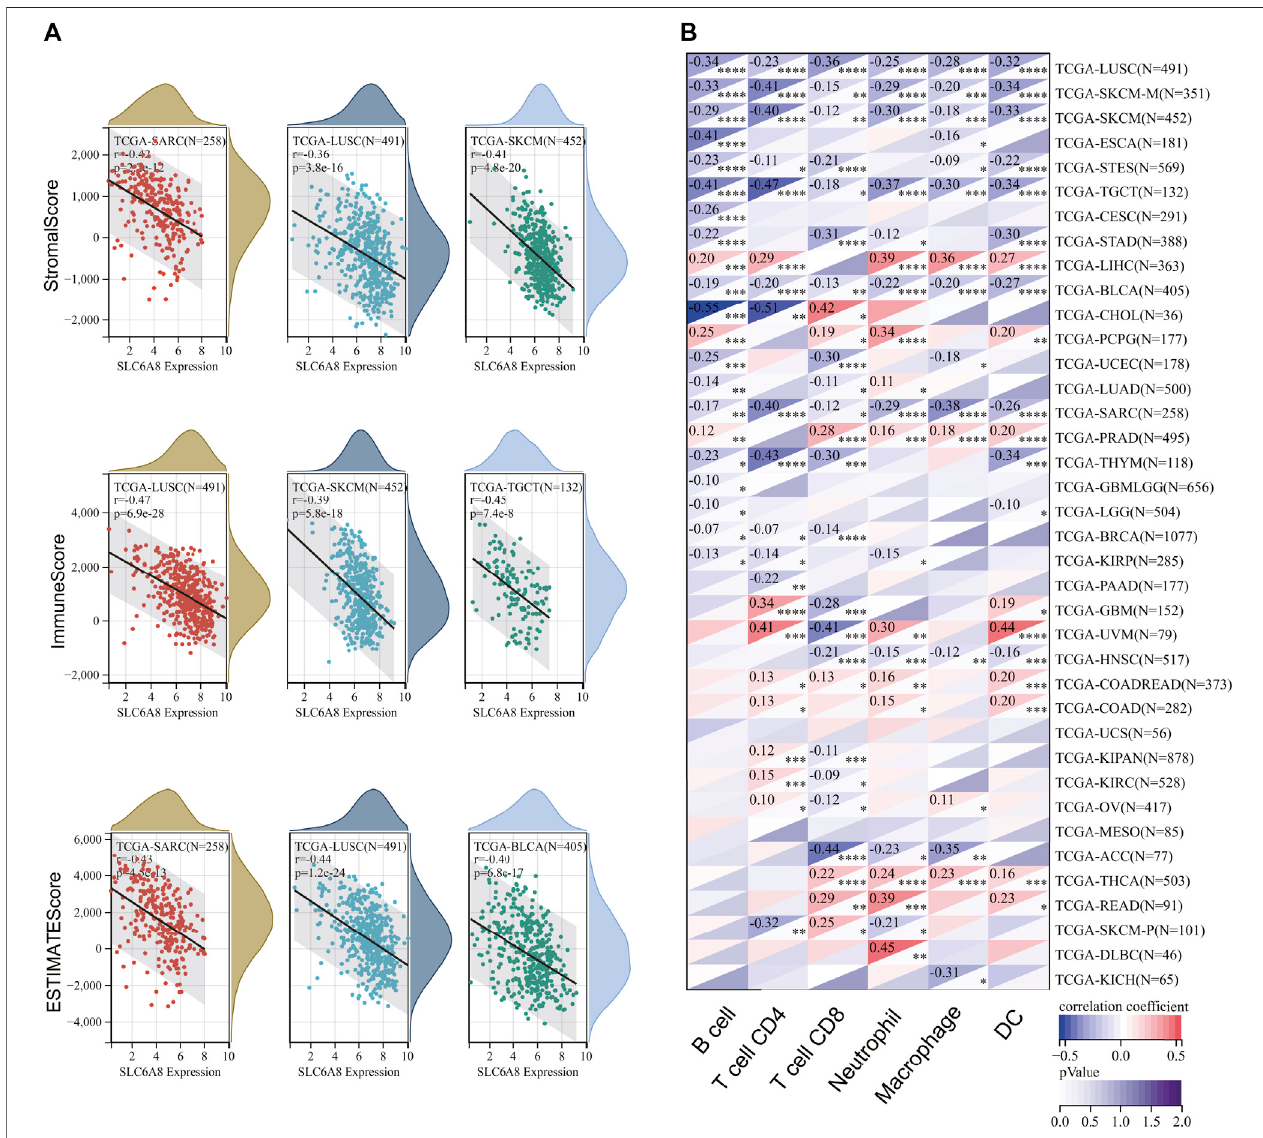
FIGURE 8 | The correlation between SLC6A8 and immune status in different cancers. (A) The negative correlation between SLC6A8 and stromal, immune, and estimate scores is the strongest in LUSC. (B) Analysis of associations between SLC6A8 expression and scores of tumor-in fi ltrating immune cells in TIMER database.